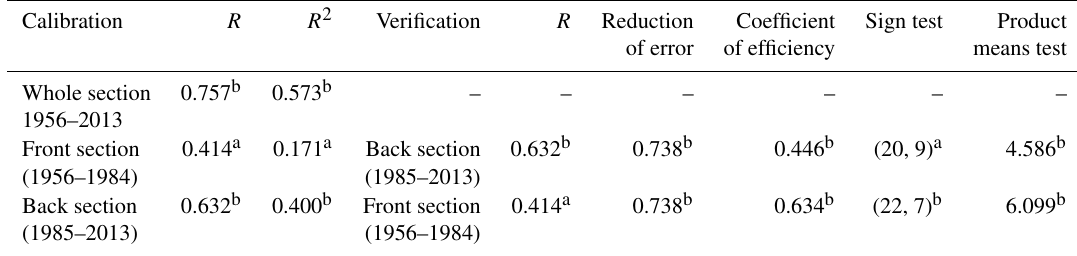
Table 3. Calibration and verification statistics of the reconstruction equation for the common period of 1956–2013.